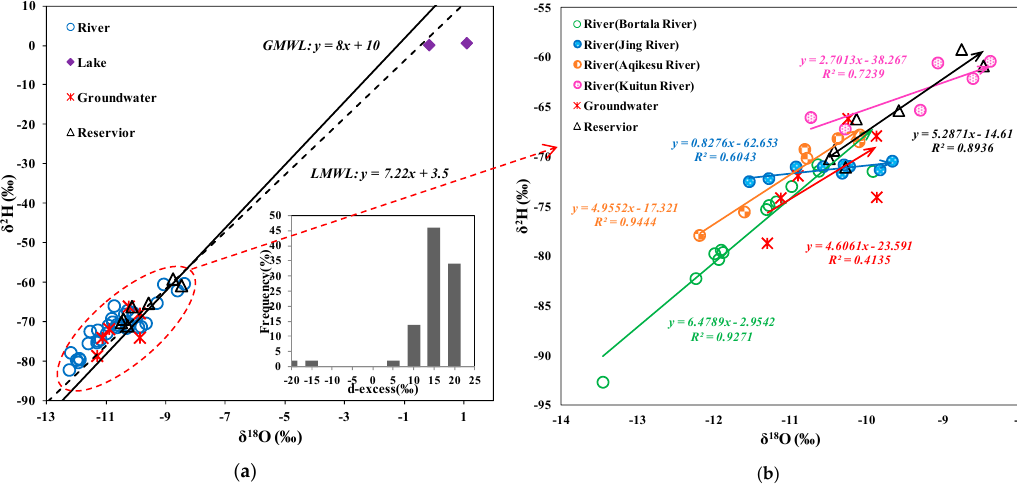
Figure 11. Relationship between hydrogen and oxygen isotope signatures of different water samples. ( a ) Relationship between δ 18 O and δ 2 H of river, lake, groundwater and reservior; ( b ) Relationship between δ 18 O and δ 2 H of river (Bortala River, Jing River, Aqikesu River and Kuntun River), groundwater and